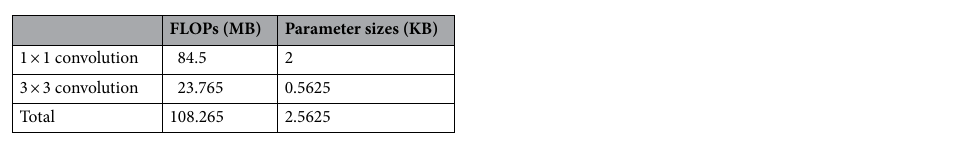
Table 3. FLOPs and parameter sizes of the first stacking module of